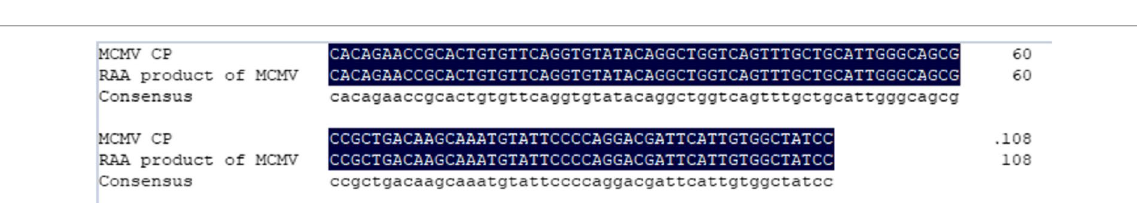
Fig. 3 Alignment of the nucleotide sequence of the RAA-amplified product against the CP gene sequence of the infectious clone of MCMV (pMCM41). MCMV CP, the partial nucleotide sequence of the CP gene of the MCMV full-length cDNA clone (pMCM41); RAA product of MCMV, the partial nucleotide sequence of the RAA-amplified product of MCMV CP